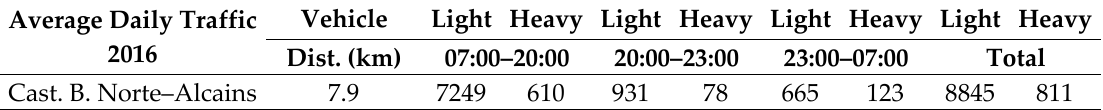
Table 1. Traffic values of vehicle used for the calculation of noise maps of Subsection in